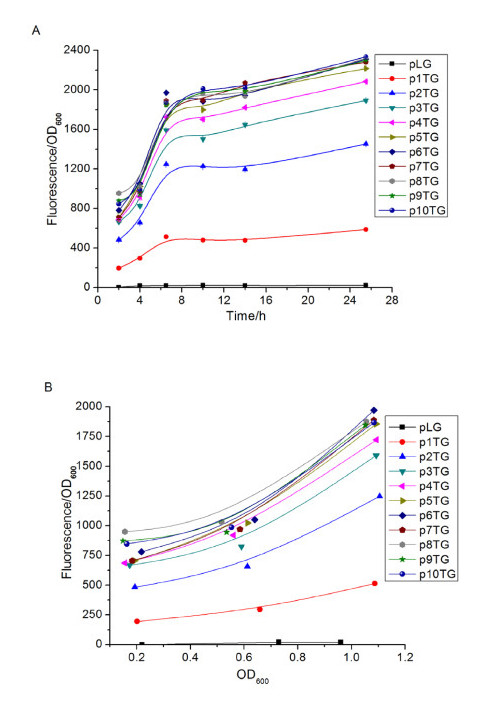
Determination of the transcription strength of the MCPtacs promoter clusters by fluorescence analysis. (A) The time dependent analysis of the fluorescence/OD600 ratio; (B) The OD600 dependent analysis of the fluorescence/OD600 ratio.